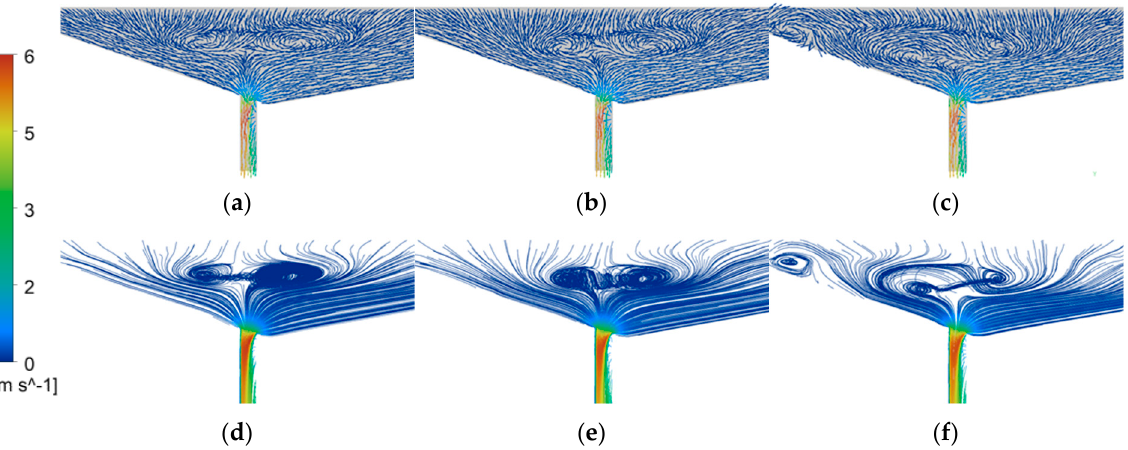
Figure 10. Velocity vector distribution of converter tapping hole with diameters of ( a ) 200 mm, ( b ) 210 mm, and ( c ) 220 mm, as well as ( d ) 200 mm, ( e ) 210 mm, and ( f ) 220 mm velocity streamlines distribution.